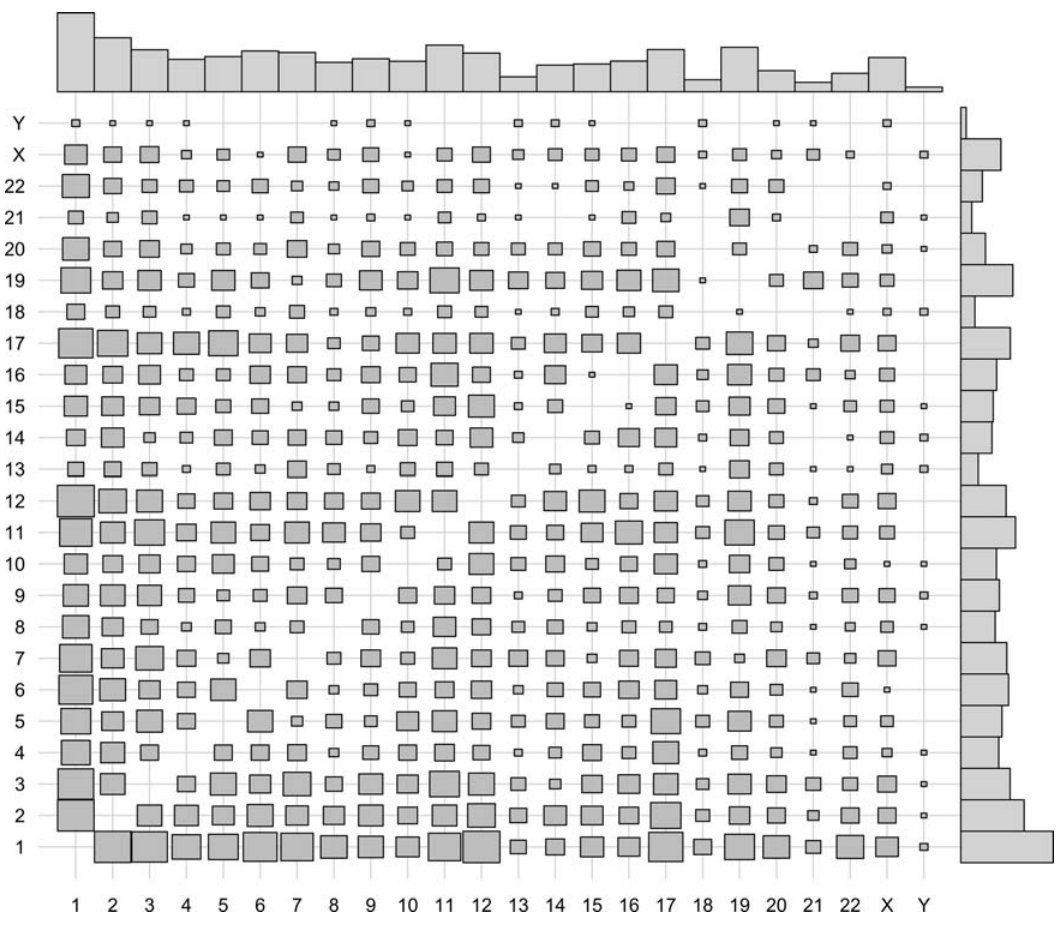
Figure 2. Gene interaction plot. Mosaic plot of gene interactions for 2651 EST chimeras where the direction of the participating partners is the same. The size of each square is proportional to the number of times a fusion event is observed between chromosomes i and j , for i , j g 1,2,…,22, X , Y . The barplots represent known gene densities on each chromosome, according to Ensembl gene counts for all chromosomes.